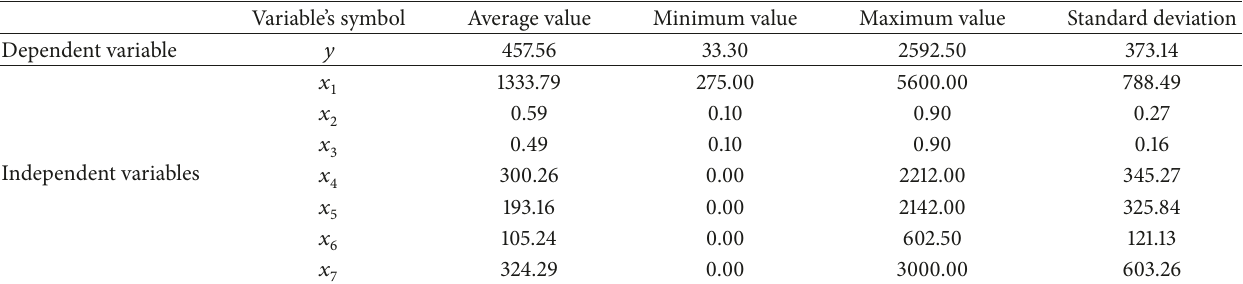
Table 5: Descriptive statistics for the models’ variables (source: own